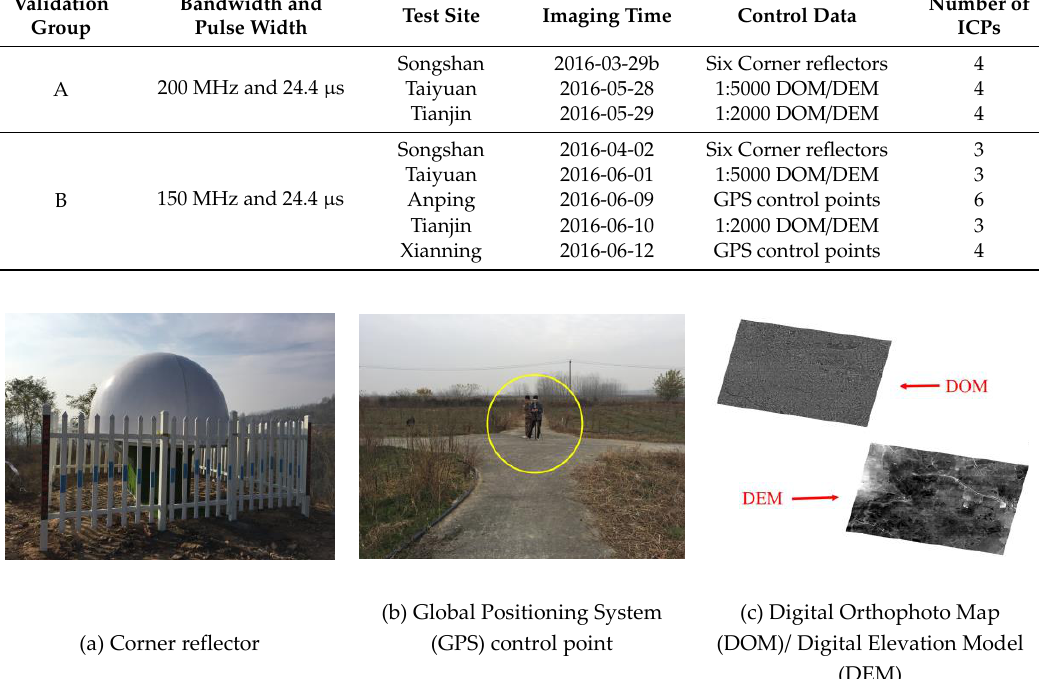
Figure 4. Sources of the three types of control data used for verification.